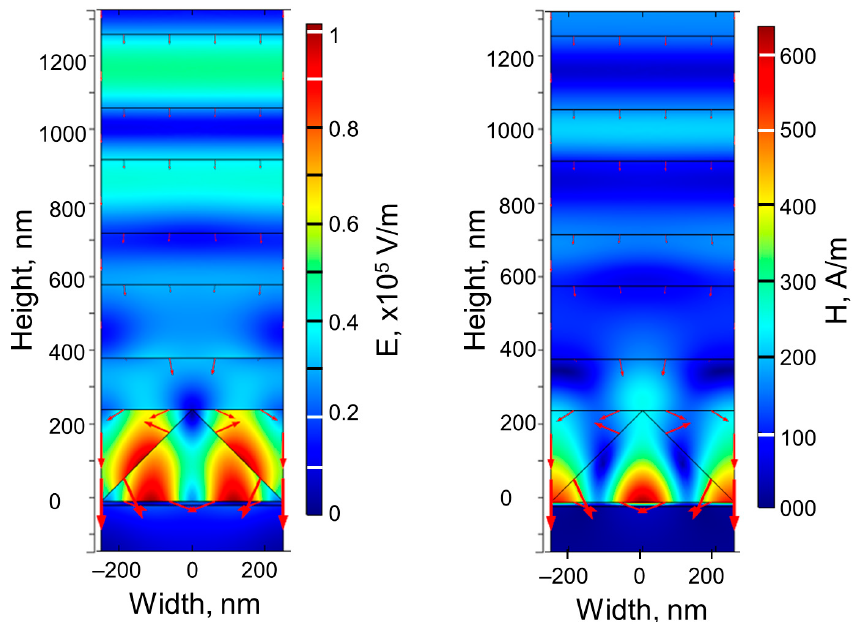
Figure 4. Spatial distribution of the electric ( left image ) and magnetic ( right image ) fields for TM polarization at 940 nm at the cross-section with an embedded blazed diffraction grating (as shown in Figure 1b). Red arrows represent the power flow.